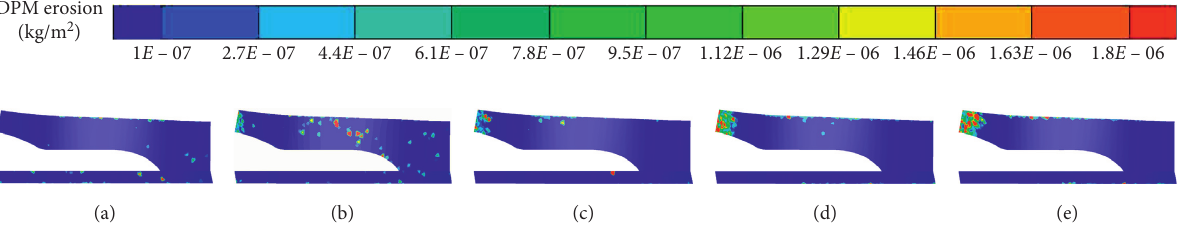
Figure 10: Suction surface wear clouds with different particle sizes. (a) d � 0.048mm, (b) d � 0.106mm, (c) d � 0.15mm, (d) d � 0.27mm, and (e) d � 0.425mm.